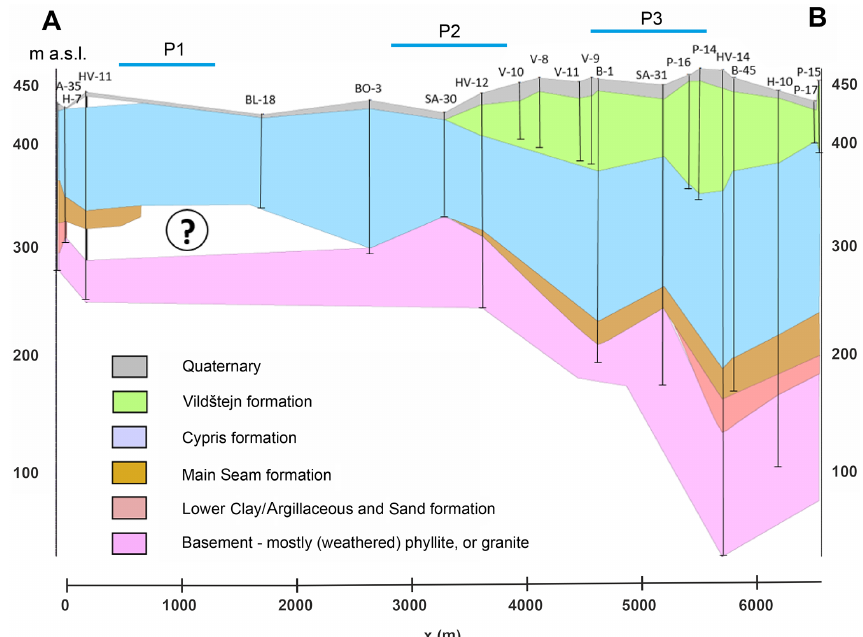
Figure 2. Lithological transect along the large-scale profile based on the descriptions of boreholes from the Czech Geological Survey (formerly GEOFOND). The question mark indicates an area of unknown lithology and the uncertainty of whether Main Seam and Lower Clay (or Argillaceous) and/or Sandy formations are present in this area. P1–P3 mark the locations of the small-scale ERT profiles. For each drill’s location, please refer to Fig.